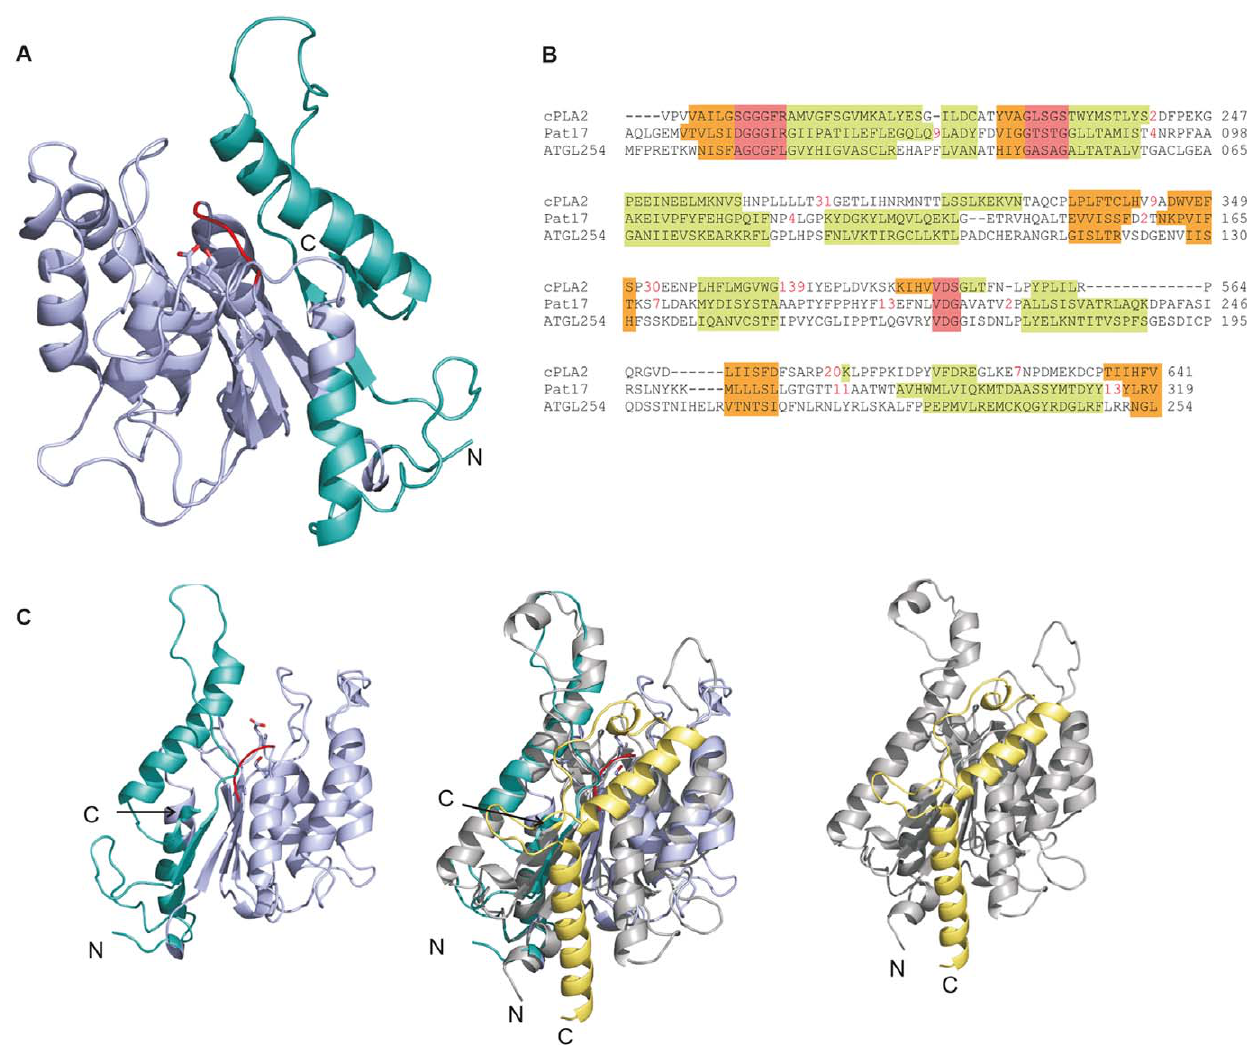
Figure 7. Model of mouse ATGL254. A. Homology-modeled structure of mouse ATGL ranging from residue Met1-Leu254 in cartoon representation. Residues Trp8-Leu178 are colored in light blue. Ser47 and Asp166, which form the catalytic dyad, are colored by atom; Gly14-Phe17, which are thought to be involved in forming the oxyanion hole are in red. N- and C-termini are indicated. B. Structural alignment of Pat17 (PDB code 1OXW) and cPLA 2 (PDB code 1CJY) with the 3D model of ATGL254. Residues at the catalytic site (oxyanion hole, GXSXG motif, catalytic Asp) are highlighted in red. a -helices and b -strands are indicated in green and orange, respectively. Red numbers indicate extra amino acids in the structure of Pat17 and cPLA 2 . C. Left panel: model of ATGL254; middle panel: overlay of the 3D model of ATGL254 with Pat17 (colored grey and yellow); right panel: structure of Pat17. Val319-Lys383 of Pat17 (yellow) suggest a possible further structural organization of approximately 60 additional residues in mATGL. doi:10.1371/journal.pone.0026349.g007 human, mouse, rat, and Drosophila melanogaster (brummer lipase, bmm) shows strong sequence conservation up to residue Leu254. Mouse and rat ATGL show 99% sequence identity within the first 278 amino acids, before the start of an apparent linker region in mouse ATGL (Gln288-Asp295), which seems to be missing in the sequence for rat ATGL. In humans, a highly conserved 253 residue long patatin domain containing protein PNPLA4 (also known as gene sequence-2 (GS2)) has also been described, hinting at a domain boundary in this region (this protein is not present in the mouse PNPLA family); and iii) Expression levels of ATGL variants: shorter variants of ATGL than ATGL254 were either misfolded, unsoluble, or degraded rapidly as deduced from the low concentration of these variants in the soluble fractions of bacterial lysates.